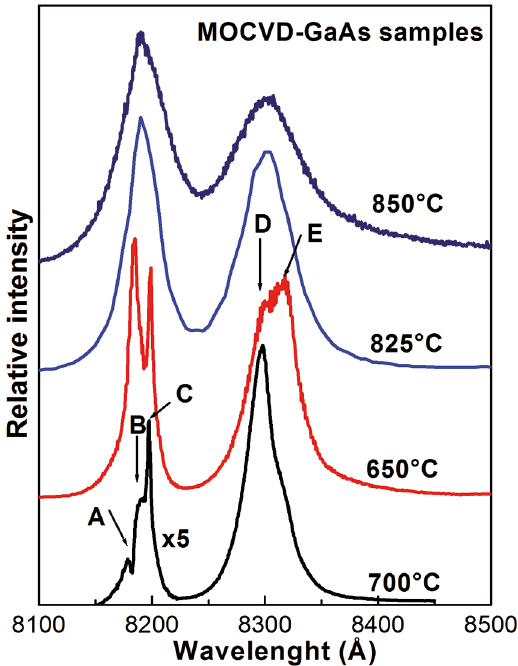
Figure 2: Photoluminescence spectra of the GaAs buffer layers grown at different substrate temperatures.